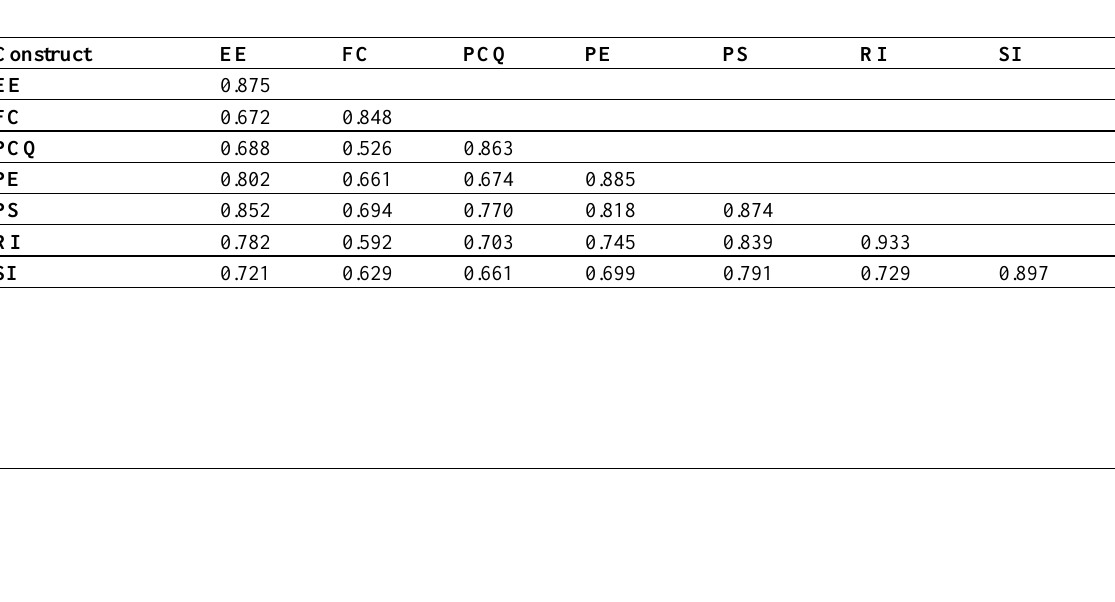
Table 3: Fornell-Larcker